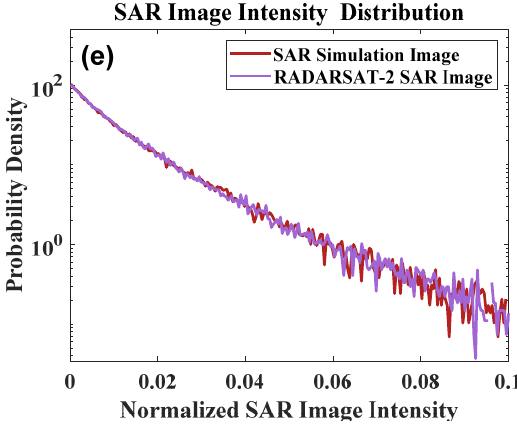
Figure 4. Same as in Figure 3, but for SAR ID 2.